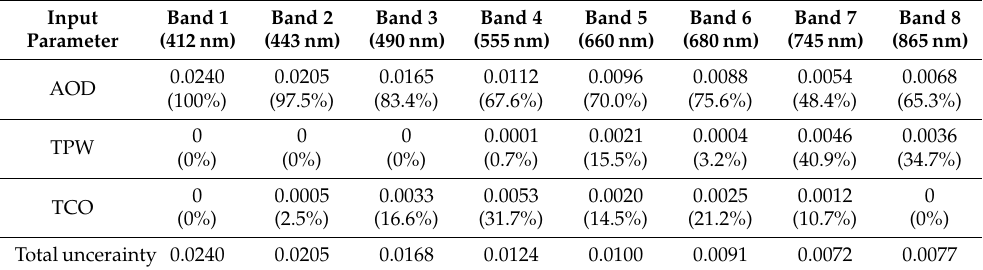
Table 4. Uncertainties introduced by AOD, TPW, and TCO, and total combined uncertainty in LSR. The numbers in parentheses indicate the contribution degree (percentage) of each input parameter to the total uncertainty in